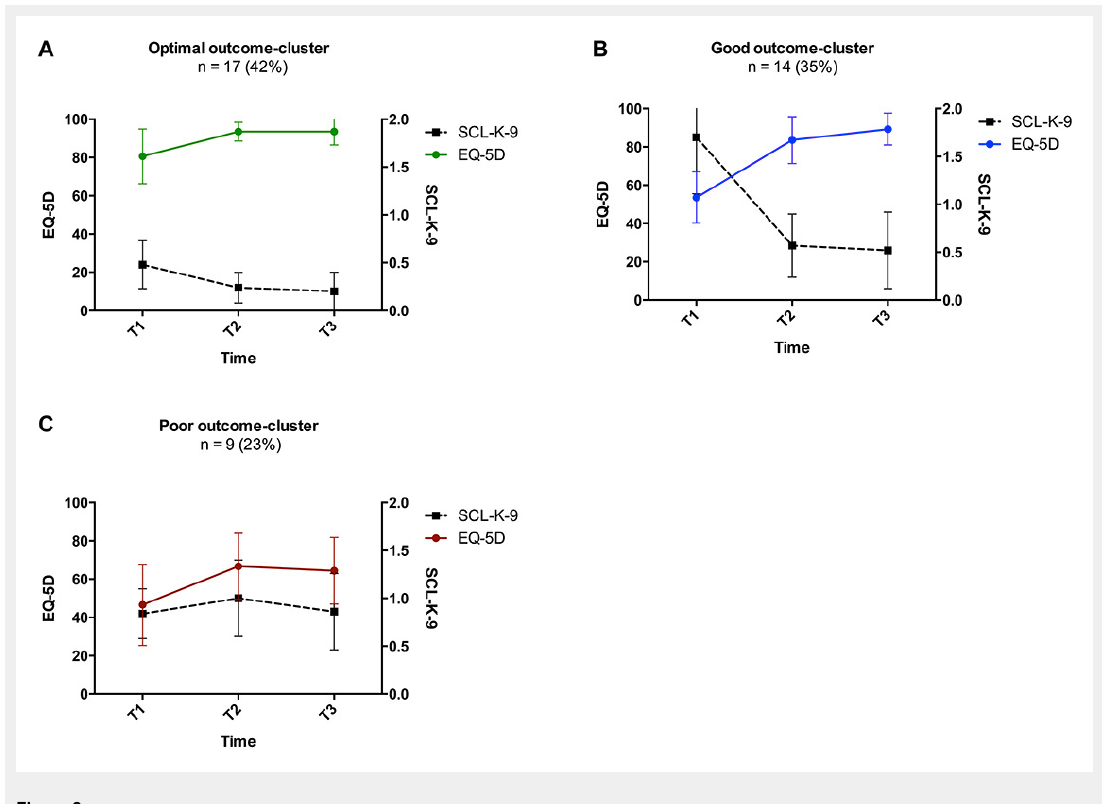
Figure 2 Post-transplant outcome clusters in lung transplant recipients. Plots A–C illustrate postoperative outcome clusters after lung transplant determined by cluster analysis. The left y-axis represents mean values for EQ-5D, while the right y-axis represents mean values for global SLK-9 values. Higher values indicate higher EQ-5D or poorer SCL-K-9 values, respectively. T1–T3 stand for the three different measurement time points (T1: 2 weeks; T2: 3 months; T3: 6 months post-transplant). EQ-5D = the EuroQOL five-dimension Health-Related Quality of Life questionnaire; SCL-K-9 =Symptom Checklist short